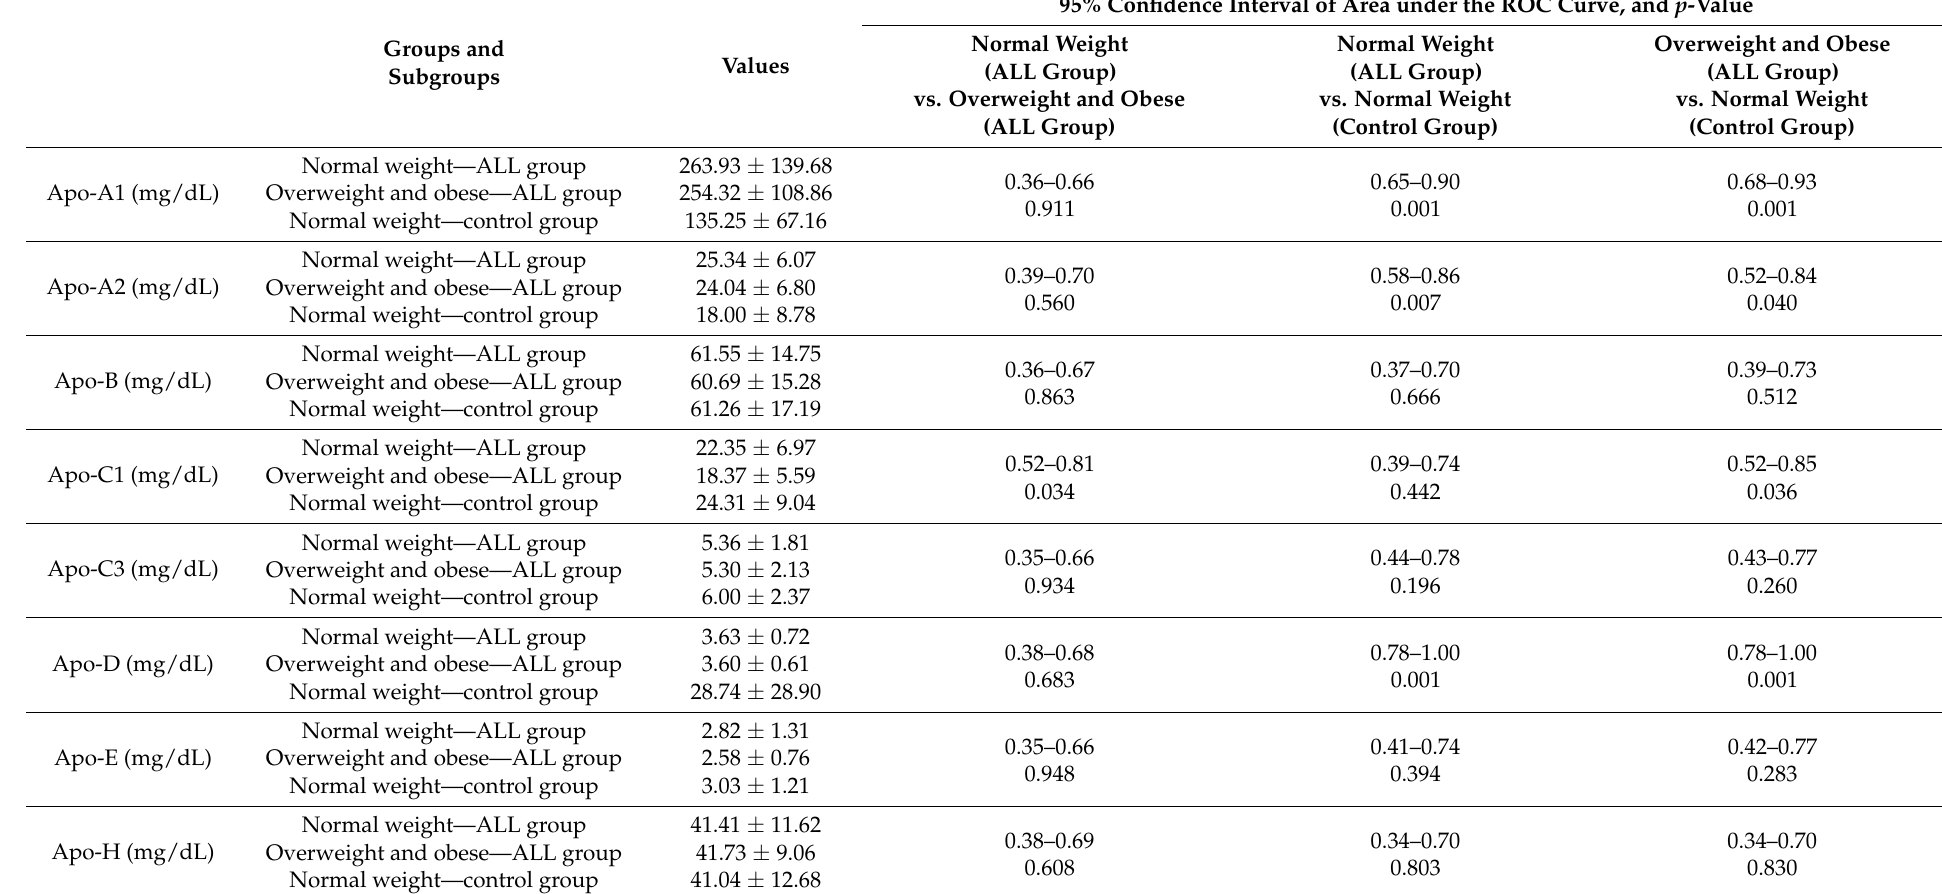
Table 2. The comparison of apolipoprotein concentrations in ALL survivors with normal weight, ALL survivors with abnormal weight, and control patients with normal